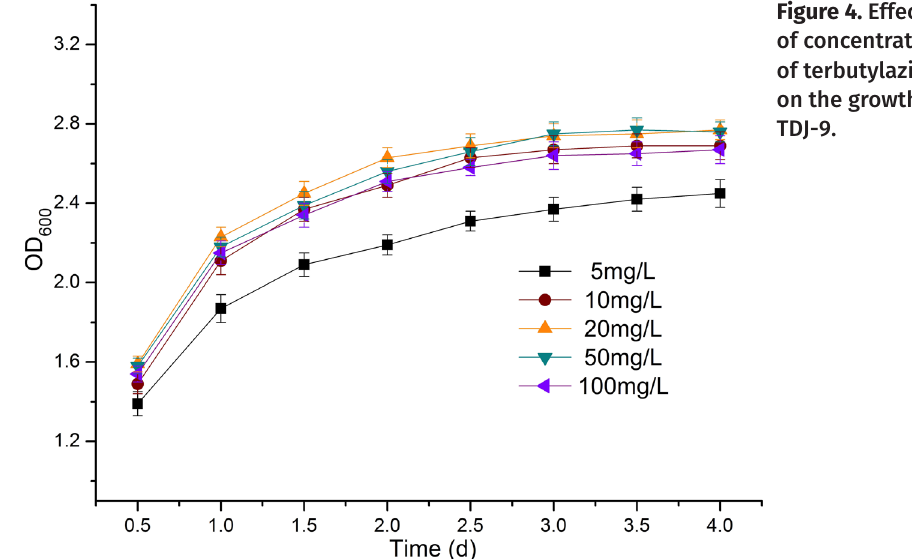
Figure 4. Effect of concentration of terbutylazine on the growth of